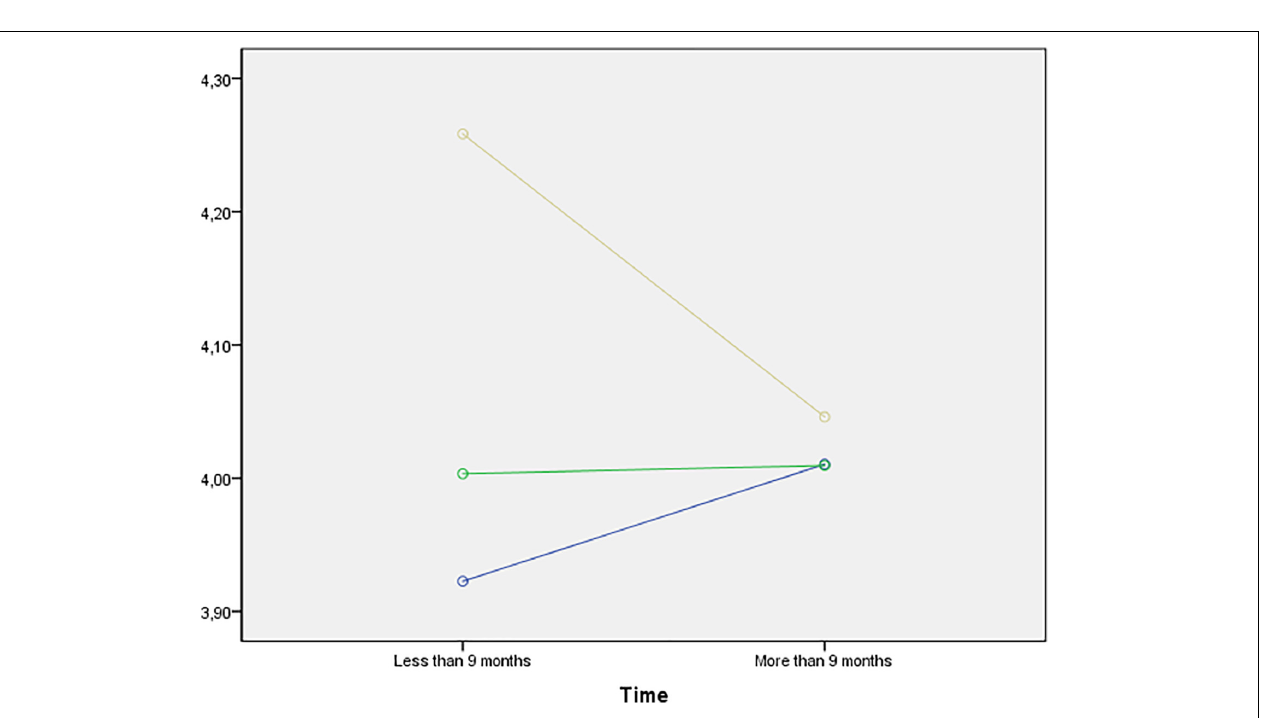
Frontiers in Psychology |